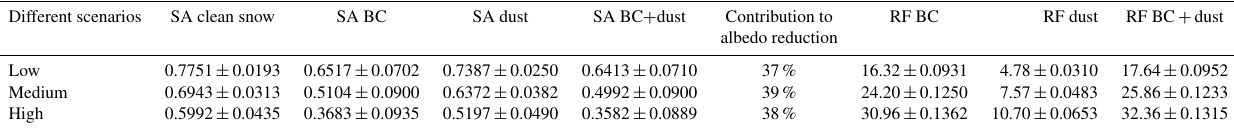
Figure 4. Back trajectory analyses for six selected sites over the Tibetan Plateau during the winter season (November 2015–February 2016). LHG and NETP in the northern Tibetan Plateau (Region III), TGL and NMC in the central Tibetan Plateau (Region II), and MYL and SETP in the southern Tibetan Plateau (Region I). The right color bar means the height (ma . s . l . ). The trajectories starting below 500hPa were taken into account. Black dots: the air parcel did not pass near a fire during the 96h prior to arrival at the studied site; green dots: the air parcel did pass by a fire between − 96 and − 48h, but not afterwards, i.e., the “contact” to a fire lies back at least 48h before the air parcel arrived at Renlongba glacier; magenta dots: contact with fires occurred between − 48 and 0h before arriving at site; red dots: contact with a fire before and after − 48h. Table 4. Simulated albedo (SA) and radiative forcing (RF) by BC and dust in snow cover across the Tibetan Plateau. Different scenarios SA clean snow SA BC SA dust SA BC +